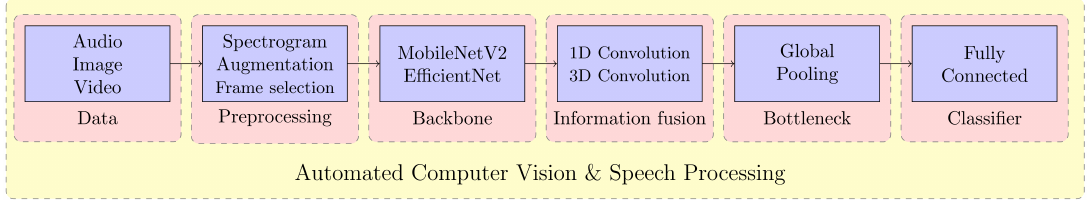
Figure 8. Future work: Block diagram of proposed automated audio-visual deep-learning